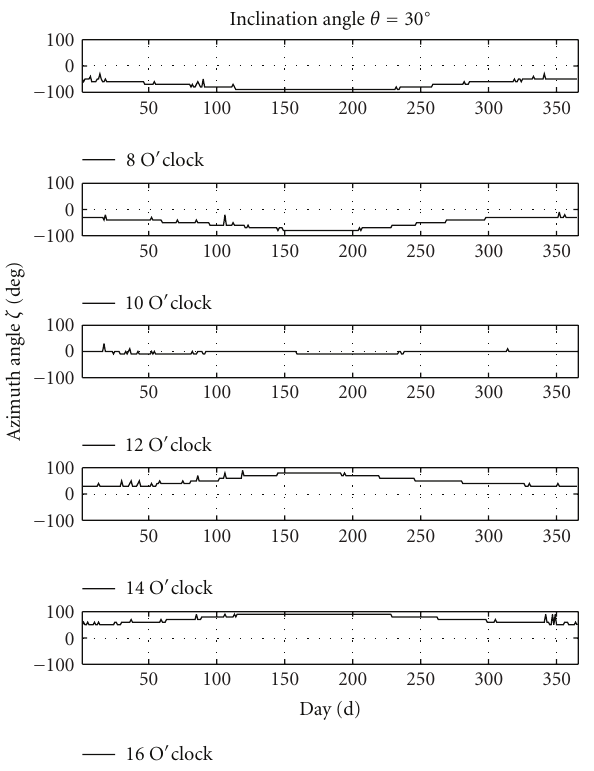
Figure 6: Optimal azimuth angles ζ for di ff erent times in the day over all the year while the inclination angle is set to θ = 30 ◦ .